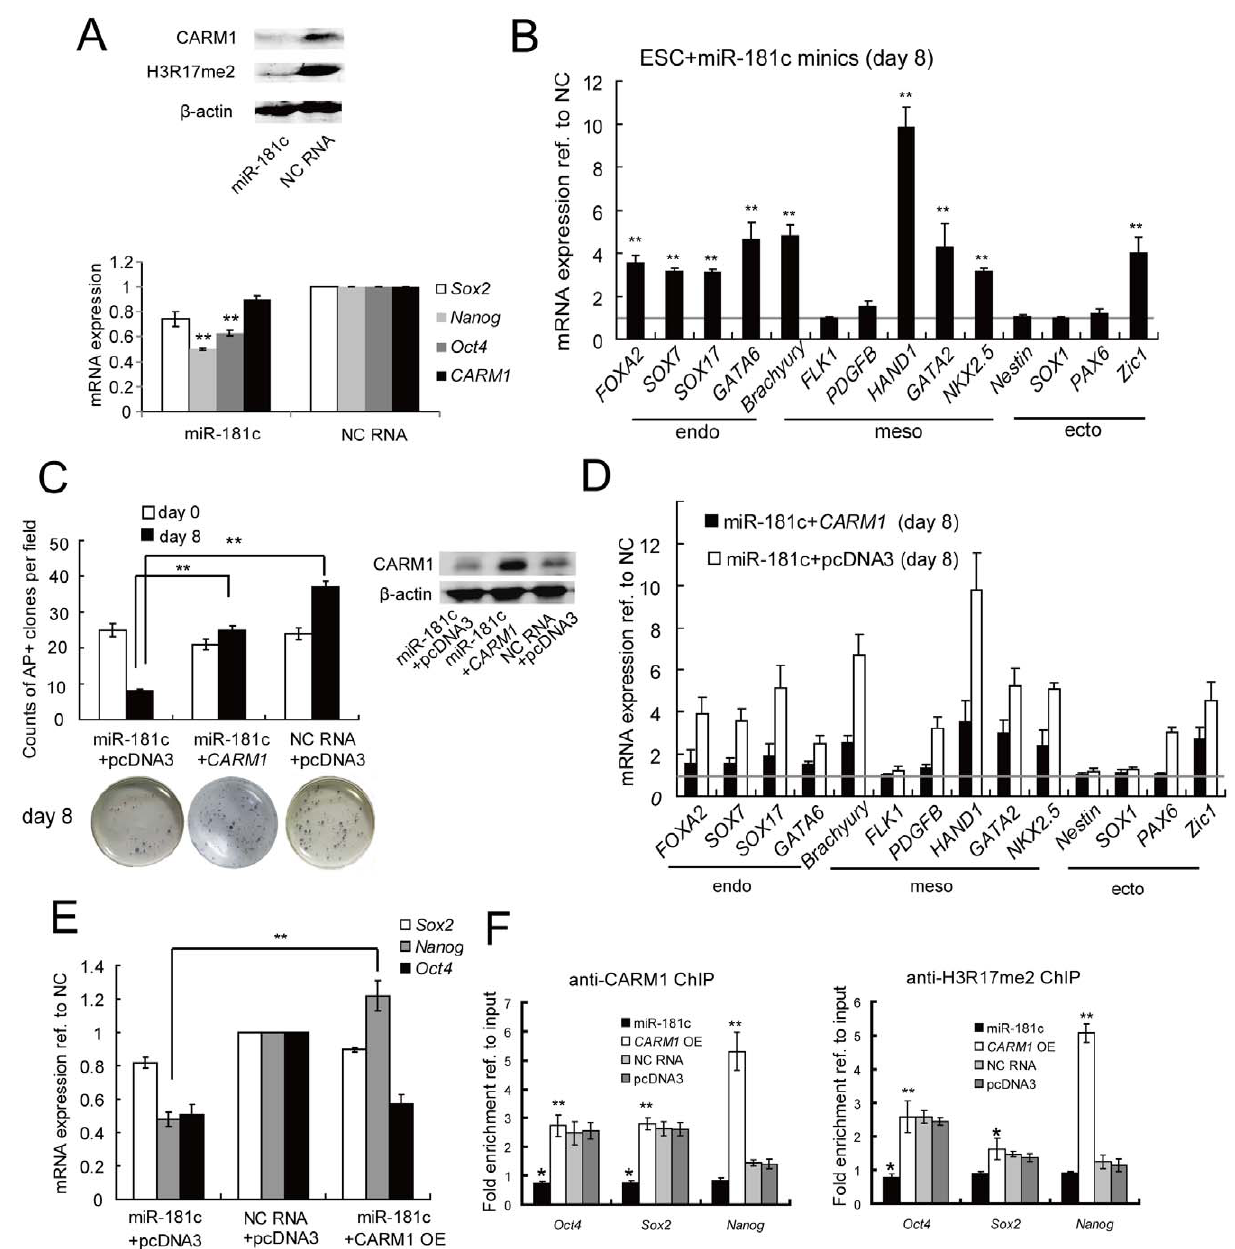
Figure 3. miR-181c leads to hESC differentiation through negative regulation of CARM1 and H3R17 methylation. (A) Overexpression of miR-181c down-regulated CARM1 expression in comparison to negative control (NC) RNA-transfected ESCs at both the mRNA and protein levels, as determined by qRT-PCR and Western blotting, respectively. H3R17 methylation level and Oct4 , Nanog and Sox2 mRNA expression were also monitored. Samples were assayed in duplicate (n=3) and normalized to endogenous b -actin expression. **, p , 0.01. (B) Expression of a subset of differentiation genes in ESCs that were transfected with miR-181c or NC RNA or were not transfected was monitored by qRT-PCR. Mean levels (after 3 days) of expression are shown relative to the NC RNA-transfected sample (shown as one fold) and normalized to b -actin expression levels. **, p , 0.01. (C, D, E) miR-181c mimics were transfected into ESCs with the 3 9 UTR-deficient- CARM1 -expressing plasmid ( CARM1 OE) or the control plasmid (pcDNA3). ESCs co-transfected with NC RNA and pcDNA3 were used as controls. (C) Pluripotency was examined by AP staining 8 days after transfection. The images for the whole plate or representative clones are shown. Scale bar: 500 m m. CARM1 protein expression is also shown. **, p , 0.01. (D) Expression of a subset of differentiation genes in ESCs transfected with miR-181c + pcDNA3 or miR-181c + CARM1 or NC RNA was monitored by qRT-PCR. Mean levels (after 3 days) of expression are shown relative to the NC RNA-transfected sample (shown as one fold) and normalized to b -actin expression levels. (E) Oct4 , Nanog and Sox2 mRNA expression was also monitored by qRT-PCR. Samples were assayed in duplicate (n=3) and normalized to endogenous b -actin expression. **, p , 0.01. (F) ChIP analysis of hESCs overexpressing CARM1 or miR-181c. ChIP was performed on sonicated chromatin using anti-CARM1 or anti-H3R17-di-me antibodies. Immunoprecipitated DNA was analyzed by qRT-PCR with primers targeting the promoter regions of the investigated gene. The fold enrichment value is shown as the normalized ChIP signal divided by the normalized input signal. Cells transfected with NC RNA or pcDNA3 were used as negative controls. The results of the electrophoretic analysis are also shown in Fig. S3A. *, p , 0.05; **, p , 0.01.